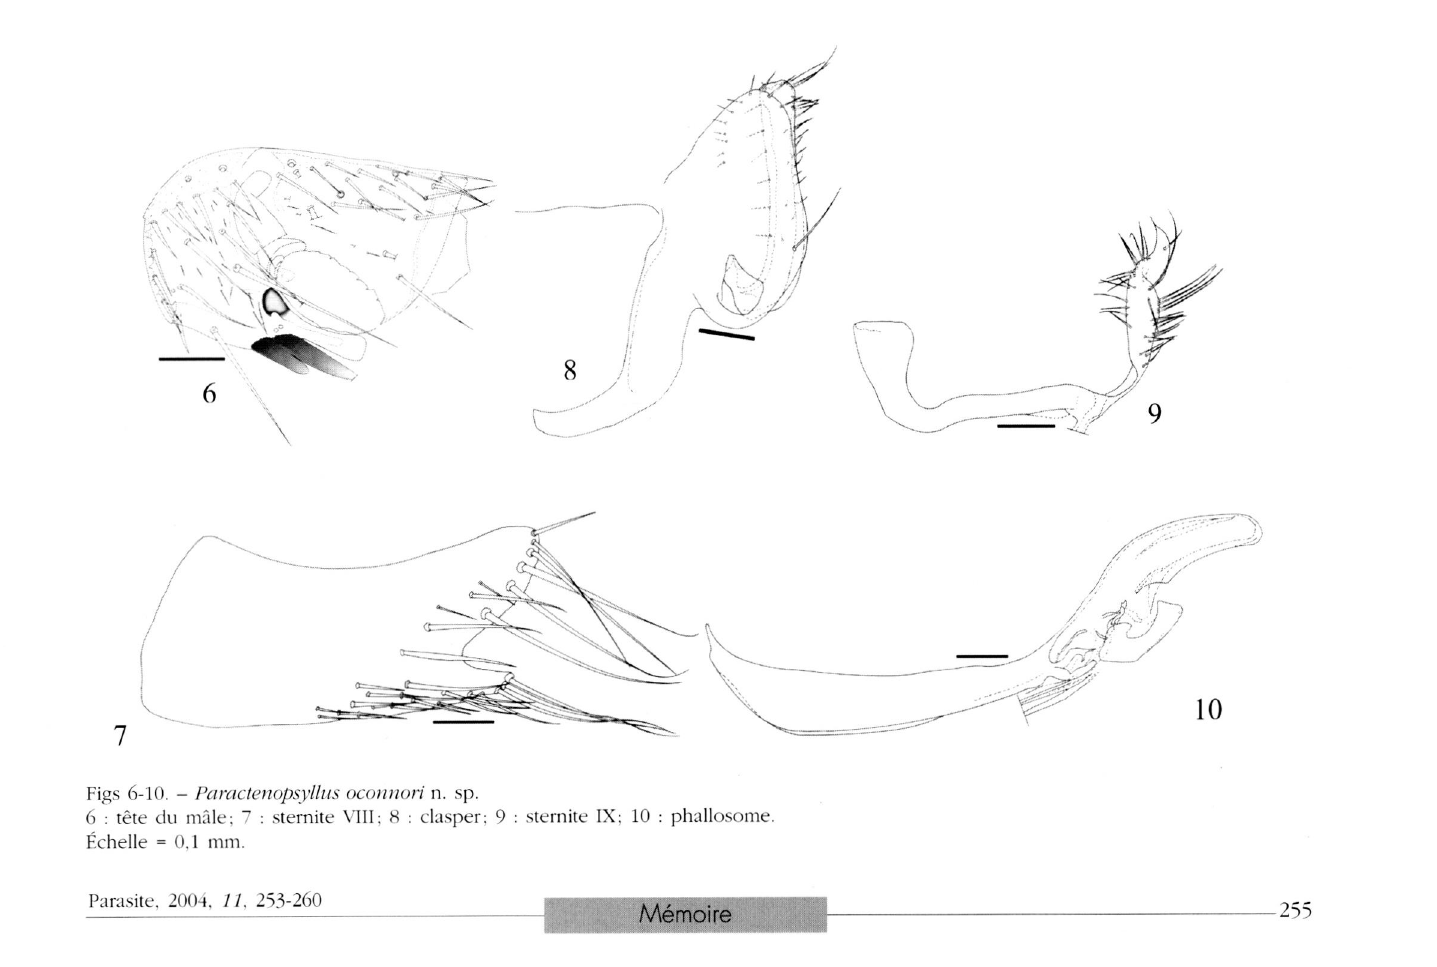
Figs 6-10. - Paractenopsyllus oconnori n. sp. 6 : tête du mâle; 7 : sternite VII: 8 : clasper: 9 : sternite IX: 10 : phallosome. Échelle = 0.1